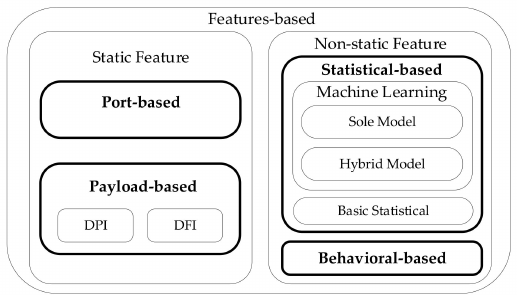
Figure 1. Categorization of tra ffi c classification